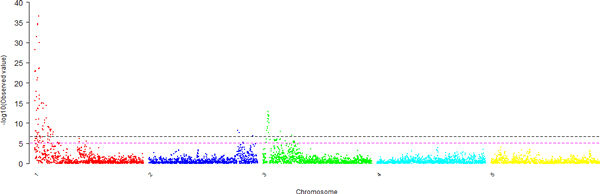
The Manhattan plots of GWAS for the 15th QTL-MAS Workshop Data. Chromosomes 1-5 are shown with different colours. The magenta horizontal dotted line indicates the significance threshold of Bonferroni correction (-log10(7.82E-6)), and the black one indicates that of permutation test(-log10(2.31E-7)).